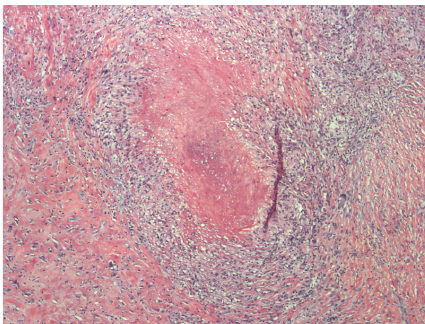
Figure1:Haematoxylinandeosinstainofbiopsyspecimenrevealed necrotizing granulomatous inflammation with small, round-oval budding yeast forms with narrow-based budding.